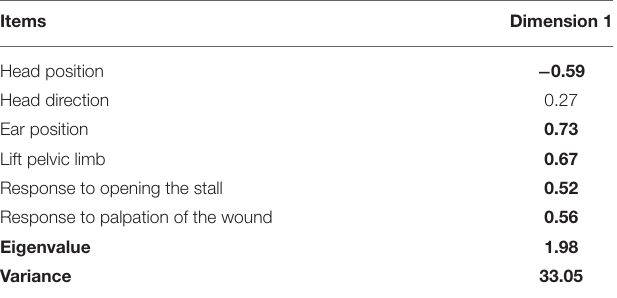
TABLE 11 | Load, eigenvalue, and variance of the DOPS.